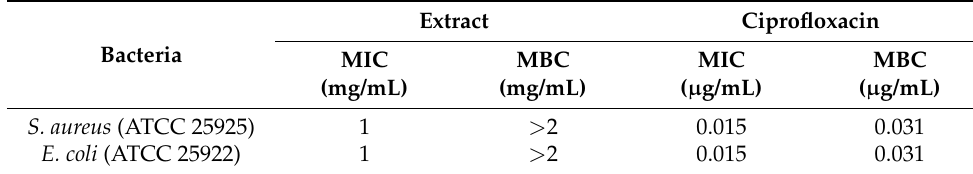
Table 2. MIC and MBC values of the fungal extract.